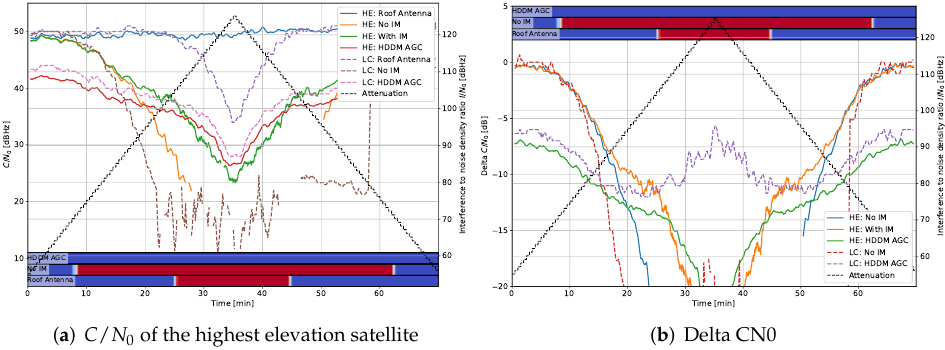
Figure A9. Interference #9: Filtered pulsed noise with 35MHz bandwidth, 50% duty cycle, and 100us pulse width with GPS